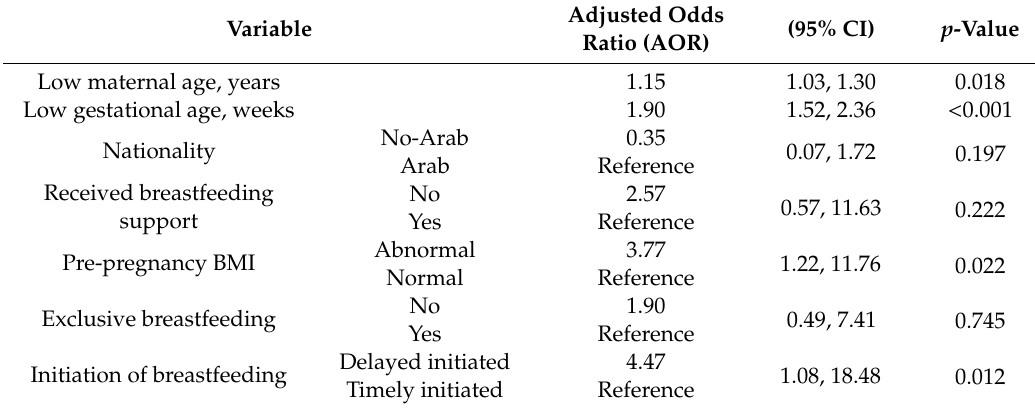
Table 2. Multivariable logistic regression analyses of factors associated with not rooming-in among mothers with infants of six months and less in Abu Dhabi,